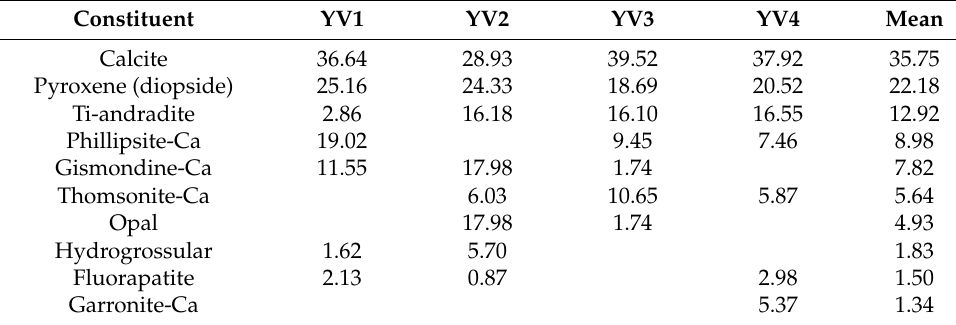
Table 2. Main minerals of the zeolite-bearing rocks and their volumes (wt.%).